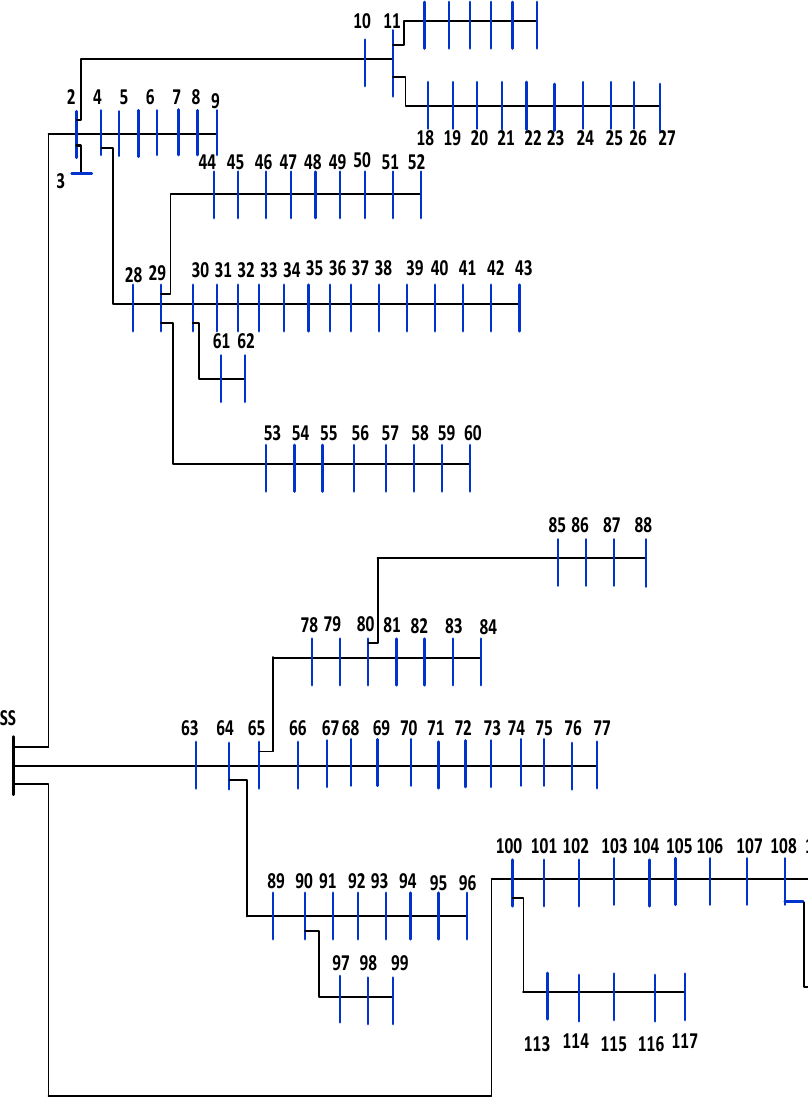
Figure 5. Single-line diagram of the IEEE 118-bus system.